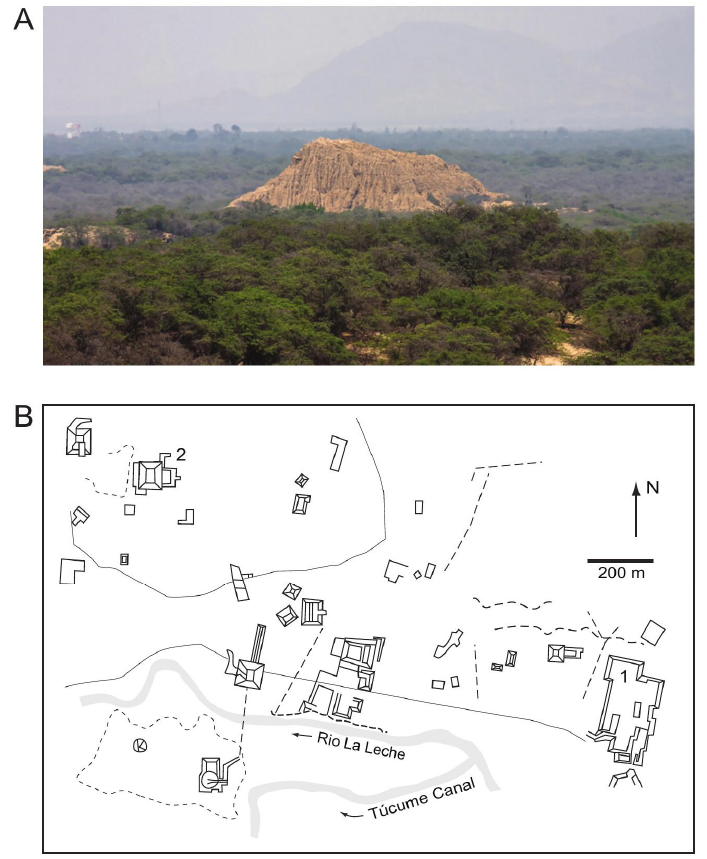
Figure 4. Batan Grande, Sicán Precinct. ( A ) Photo of the Huaca El Loro mound at Batan Grande. (Photo credit: https://commons.wikimedia.org/wiki/File:Huaca_El_Loro_(El_oro)_-_Vista_desde_el_Cerro_Las_Salinas.jpg (accessed on 22 May 2022). ( B ) Schematic map of the Sicán Precinct at the Batan Grande site. 1 = Huaca El Corte; 2 = Huaca Rodillona; Huaca El Moscon (also known as Huaca Colorada) is off the map to the south. (Map adapted by Kirk A. Maasch from [2]: Figure 5).